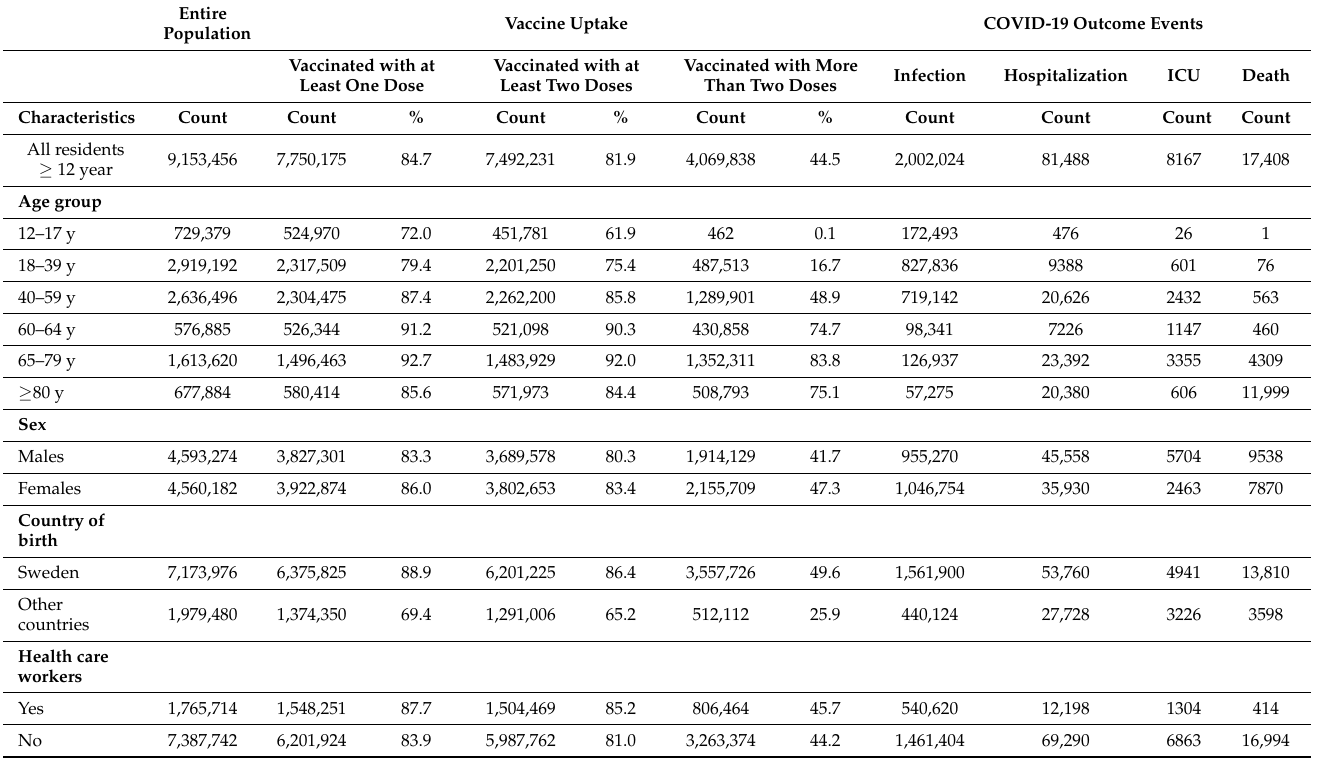
Table 1. Sociodemographic and comorbidity characteristics of the study cohort according to vaccine uptake and COVID-19 outcomes by 31 January